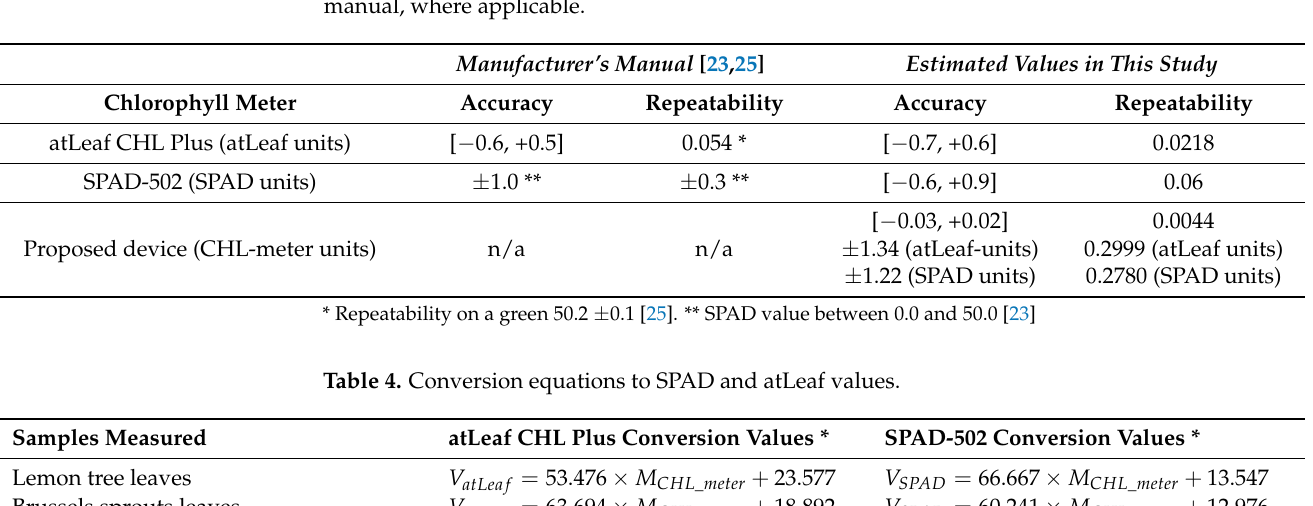
Table 3. Accuracy and repeatability as estimated in this study and as compared to the manufacturers’ manual, where applicable.